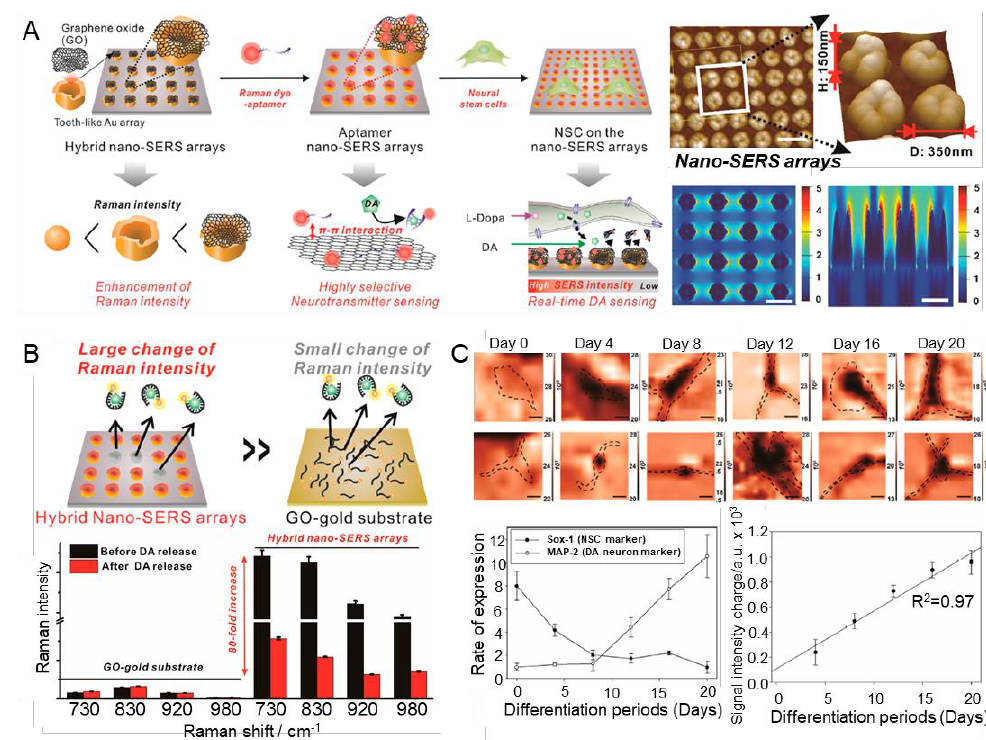
Figure 5. Metal/graphene-hybrid-based aptamer sensors for DA detection. ( A ) Schematic illustration of the fabrication process of metal/graphene-hybrid-based aptamer sensors. ( B ) Schematic illustration and plot indicating SERS signal change. ( C ) Raman mapping images by differentiation process and plot indicating the real-time DA-sensing performance. With permission from [68]. Copyright ACS. SERS, surface-enhanced Raman scattering; NSC, neural stem cell; DA, dopamine; GO, graphene oxide.